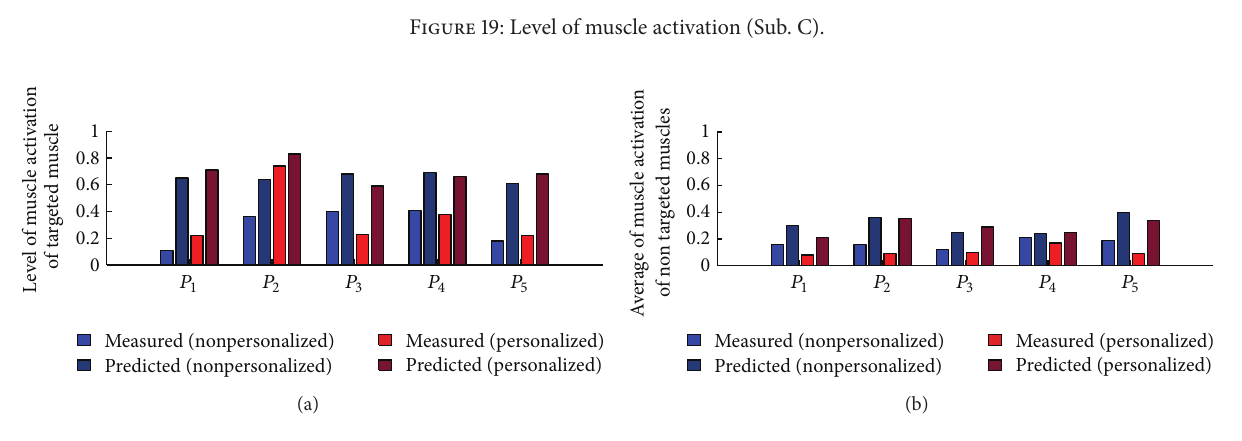
Figure 19: Level of muscle activation (Sub. C).